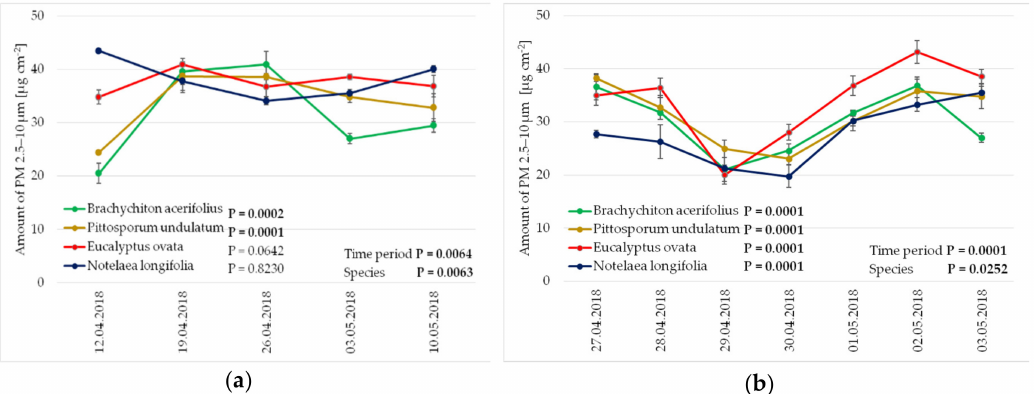
Figure 4. Amount of coarse PM fraction (2.5–10 µ m) PM deposited on leaves of B. acerifolius, P. undulatum , E. ovata and N. longifolia during ( a ) five weeks and ( b ) seven days of measurements. Data are means ± SE, n = 3. P values in bold indicate statistical significance.